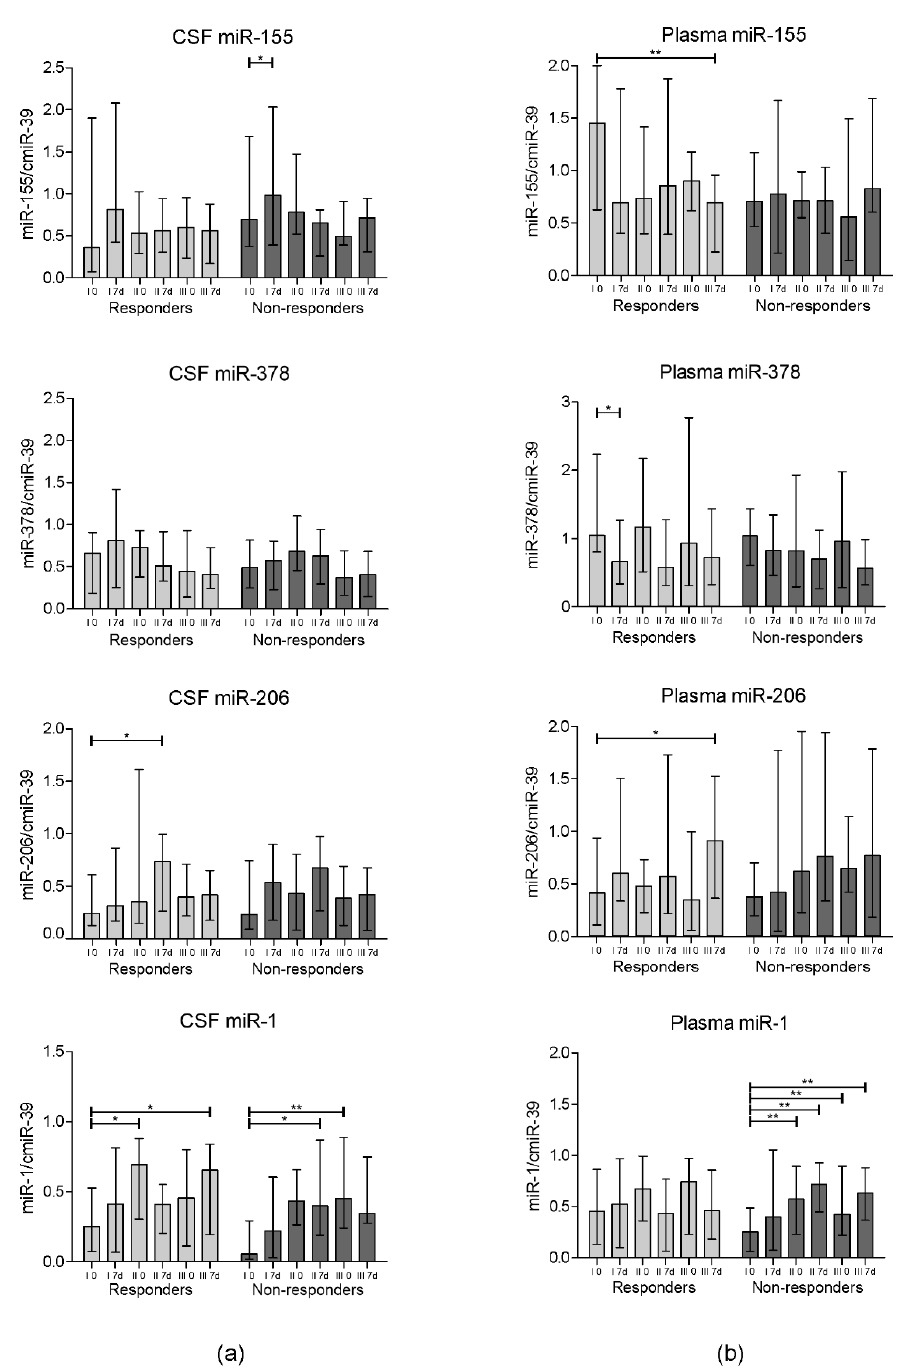
Figure 3. Relative expression of miR-155, miR-378, miR-206, and miR-1 in the bodily fluids of ALS patients before (0) and one week after (7 d) each of the cell administrations (I, II, and III) in: ( a ) CSF; ( b ) plasma. Data are presented as the median value with the interquartile range. Statistical testing between different timepoints in each of the analyzed groups (responders and non-responders) was performed using the Wilcoxon signed-rank test. To compare certain timepoints between the groups, the Mann–Whitney U test was applied. Level of significance—* p < 0.05, ** p < 0.01.